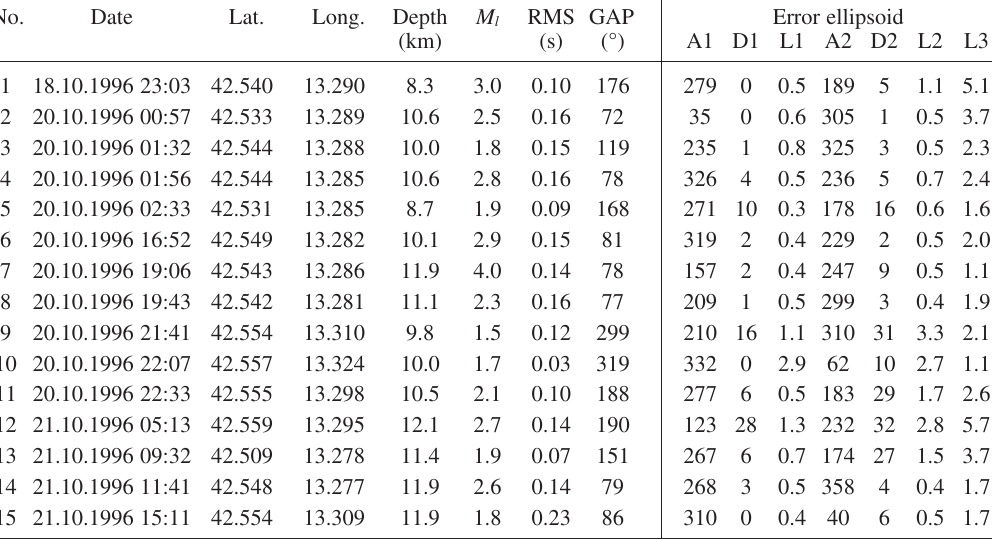
Table I. Hypocentral parameters of the October 1996 seismic sequence computed with the Hypoellipse soft- ware (Lahr, 1999), using the 1D velocity model of fig. 2b. A, D and L are the azimuth (°), dip (°) and length (km) of the 3 error ellipsoid semi-axes, respectively. No. Date Lat. Long. Depth RMS